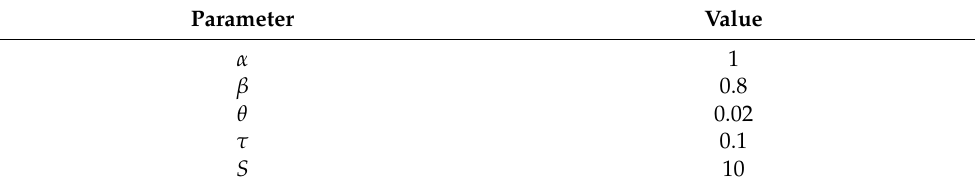
Figure 5. The concentration of molecule p under various Hill coefficients when a = b for Fernando’s model. ( a – d ) Results when a = 1,2,3,4. α = 1, β = 0.8, θ = 0.02, τ = 0.1, S = 10, respectively. Table 2. Parameter values used in the simulation for Fernando’s model (Equation